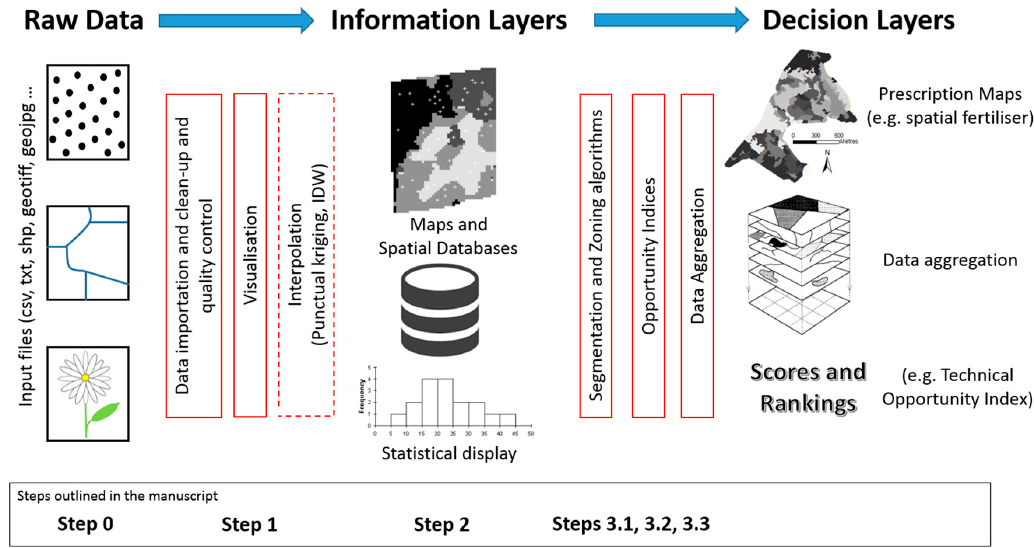
Figure 2. Generic flow of data in precision agriculture with main processing steps from raw data processing to decision-making.